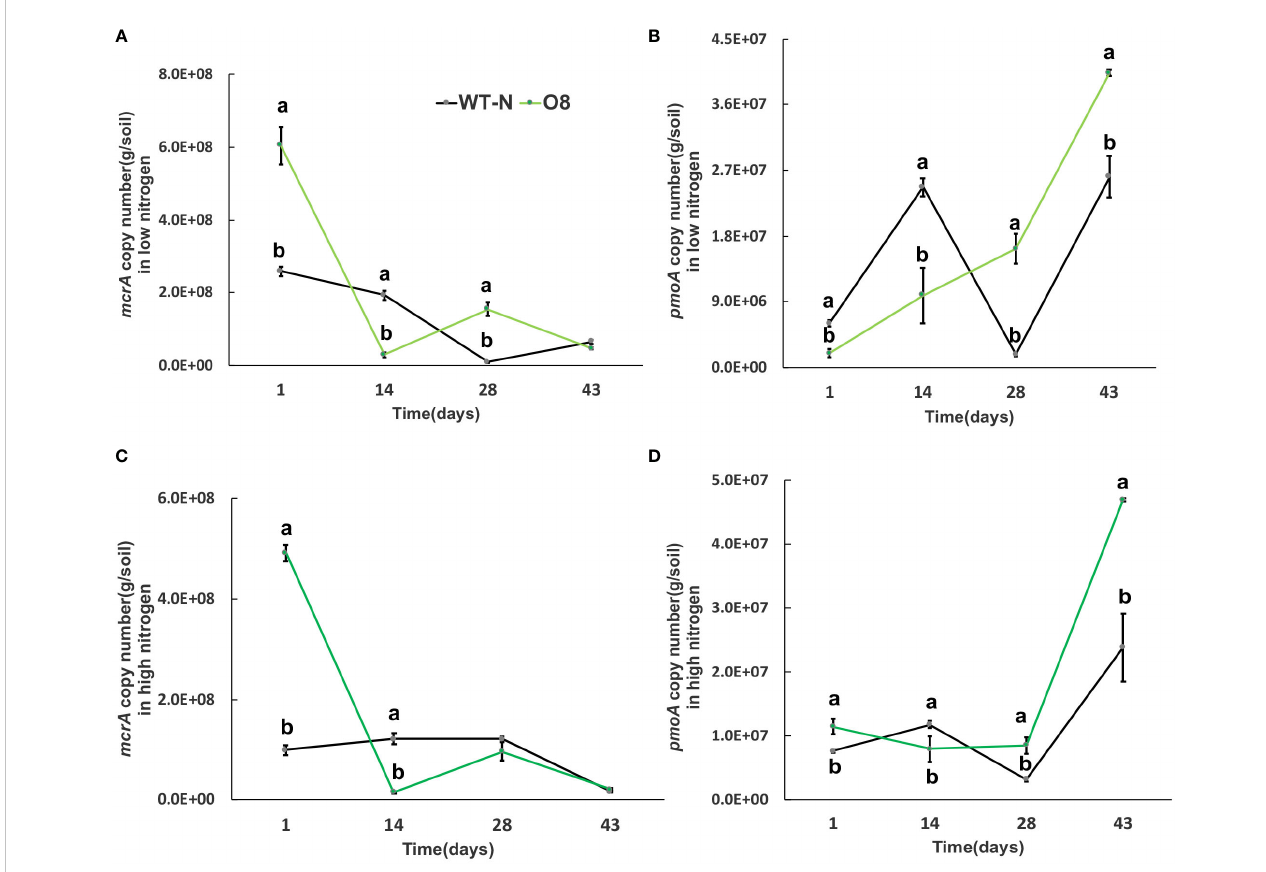
FIGURE 7 The abundance of mcrA and pmoA genes in low and high Nitrogen soil of WT-N and O8. X-axis shows the soil sampling time (days), from the fi rst measurement after transplanting seedlings from nursery to fi eld. Figures (A, C) show the mcrA copy number/g of soil. Figures (B, D) show the pmoA copy number/g of soil. Error bars: SE (n = 3). Signi fi cant difference between WT and O8 are indicated by different letters: a= high value, b= lower value ( t -test, p<